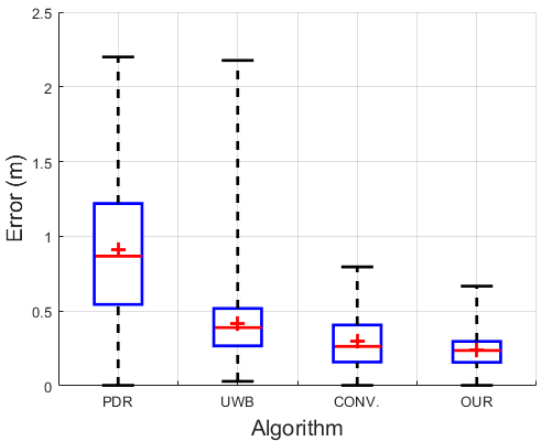
Figure 16. CDF of positioning errors in multi-lap LOS+NLOS scenario.